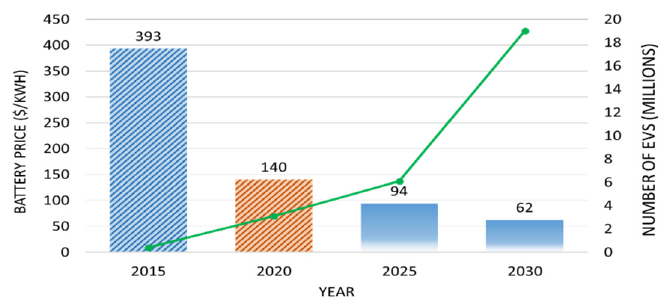
Figure 1. Battery prices and number of EVs prediction until 2030 [2].